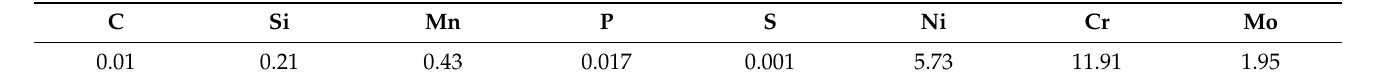
Table 1. Chemical composition of the MMSS steel used in this work (% w / w ), balance Fe.